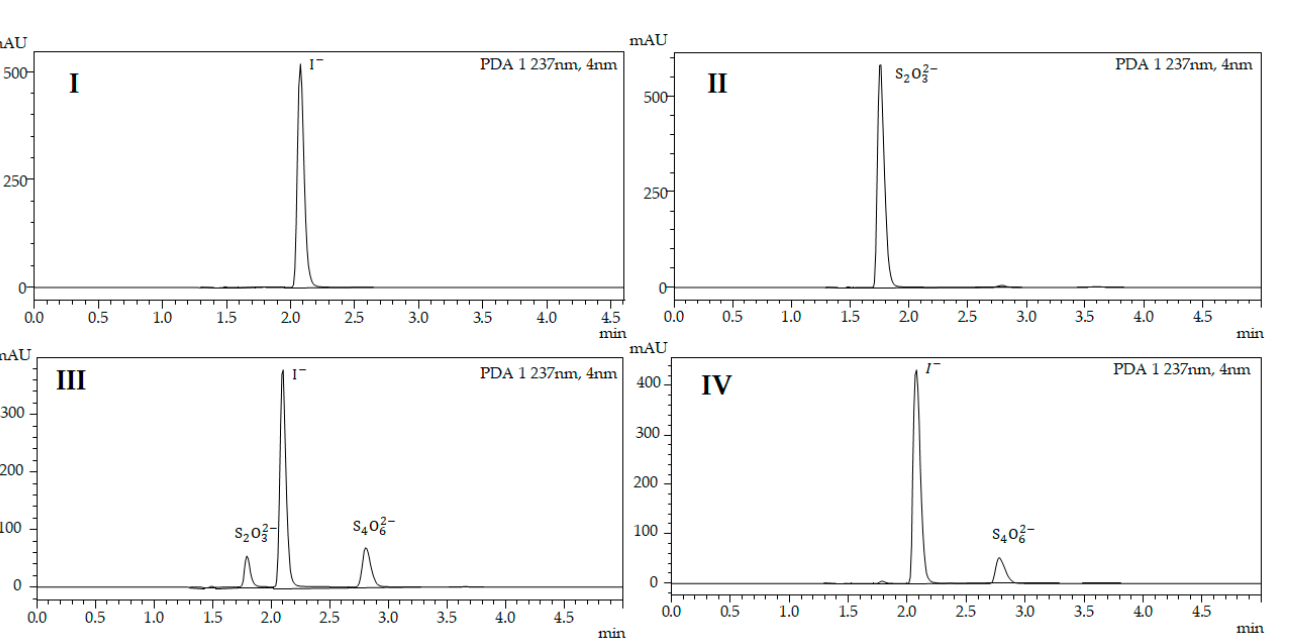
Figure 2. ( I ) Chromatogram of standard solution of potassium iodide; ( II ) Chromatogram of standard solution of sodium thiosulfate; ( III ) Chromatogram of iodine/ β -CD complex with an excess amount of thiosulfate; ( IV ) Chromatogram of iodine/ β -CD complex with an equivalent amount of thiosulfate.